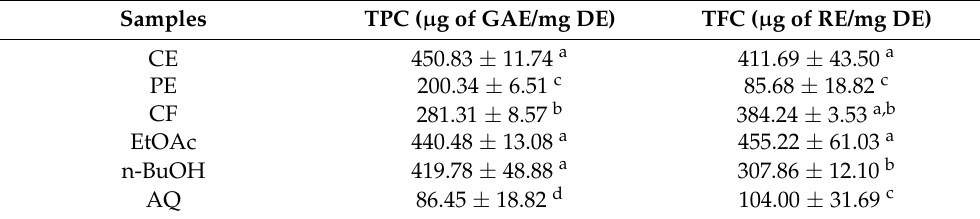
Table 1. Total phenolic and flavonoid content in P. frutescens leaf extract and its fractions.